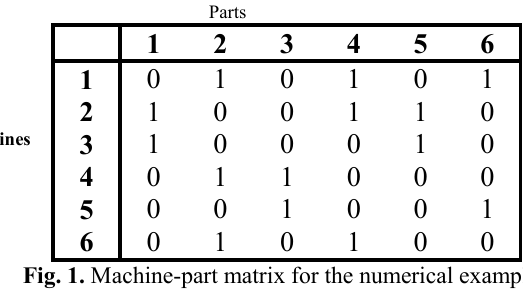
Fig. 1. Machine-part matrix for the numerical example